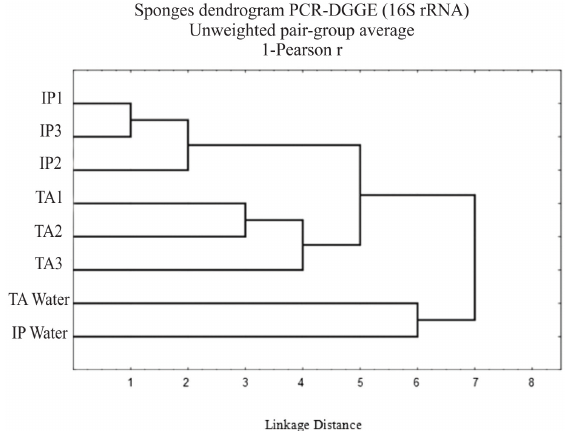
Figure 1 - Dendrogram generated using Statistica software (using Pearson and UPGA similarity coefficient) to analyze the DGGE bands profiles of samples of water and sponge H. heliophila of Itaipu (IP) and Tartaruga (TA)